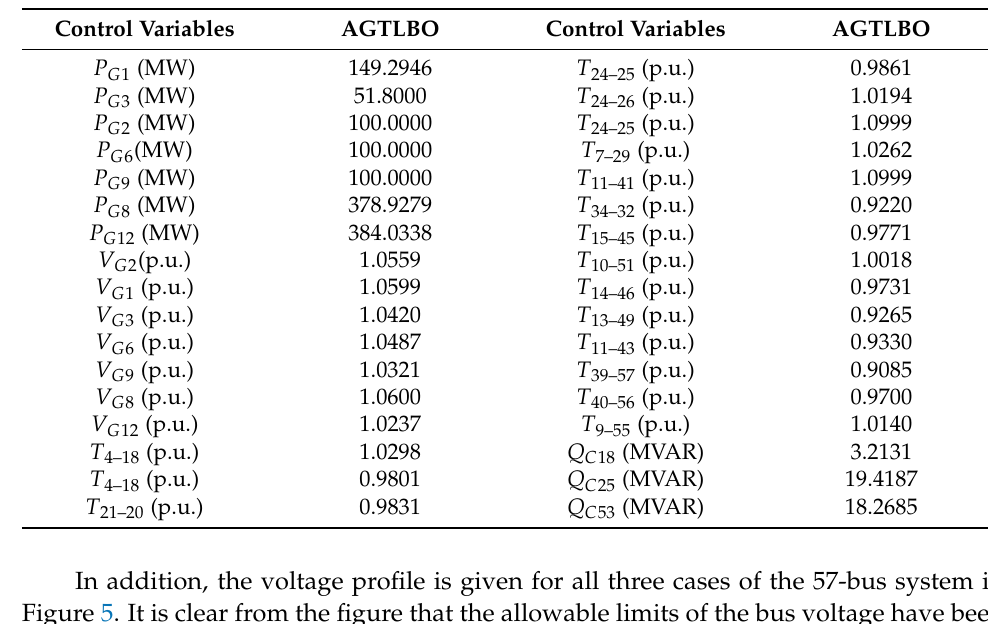
Table 15. Optimal decision variables settings for Case 11.